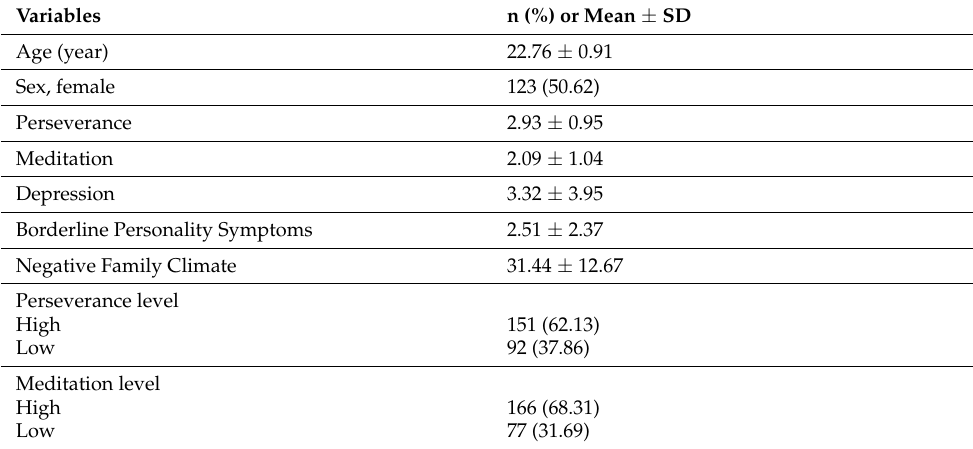
Table 1. Sociodemographic and clinical data.